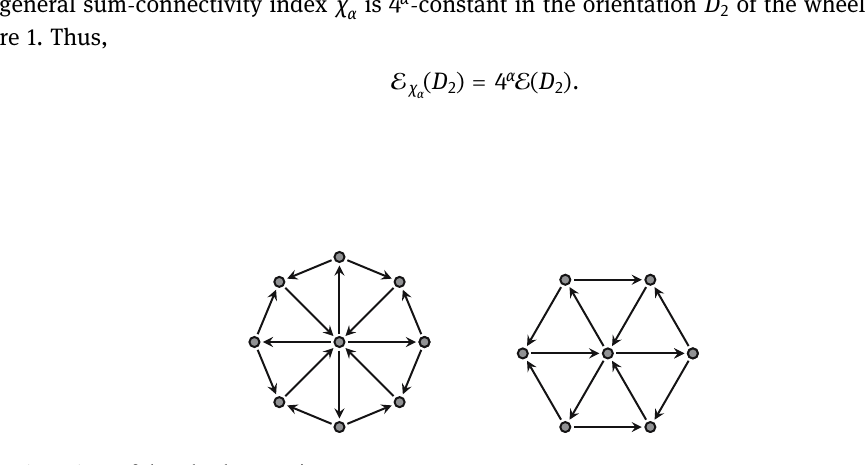
Figure 1: Orientations of the wheels W 9 and W 7